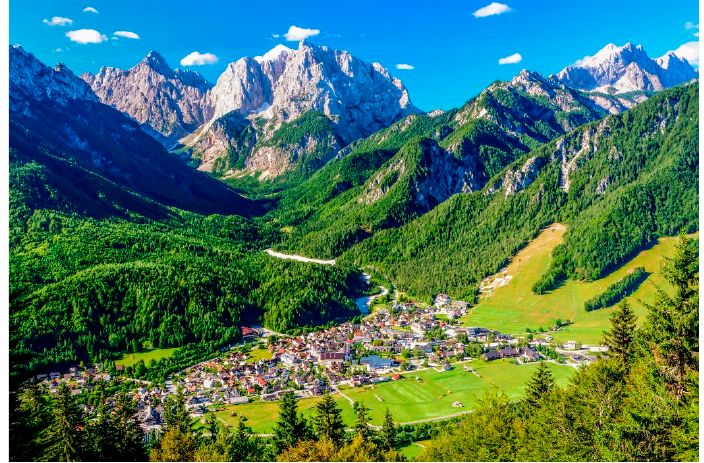
Figure 1. Kranjska Gora valley .